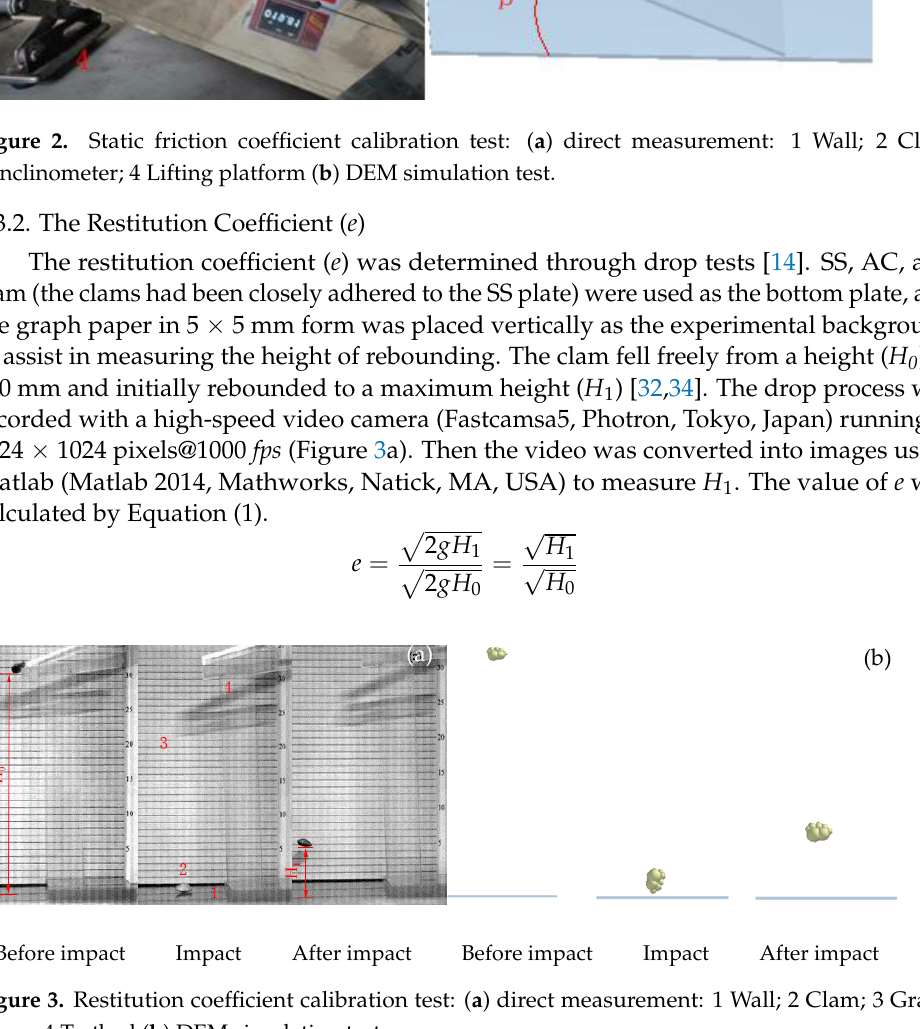
896 Table 1. The initial set of material parameters for AC, SS, and Clam. Material Parameters